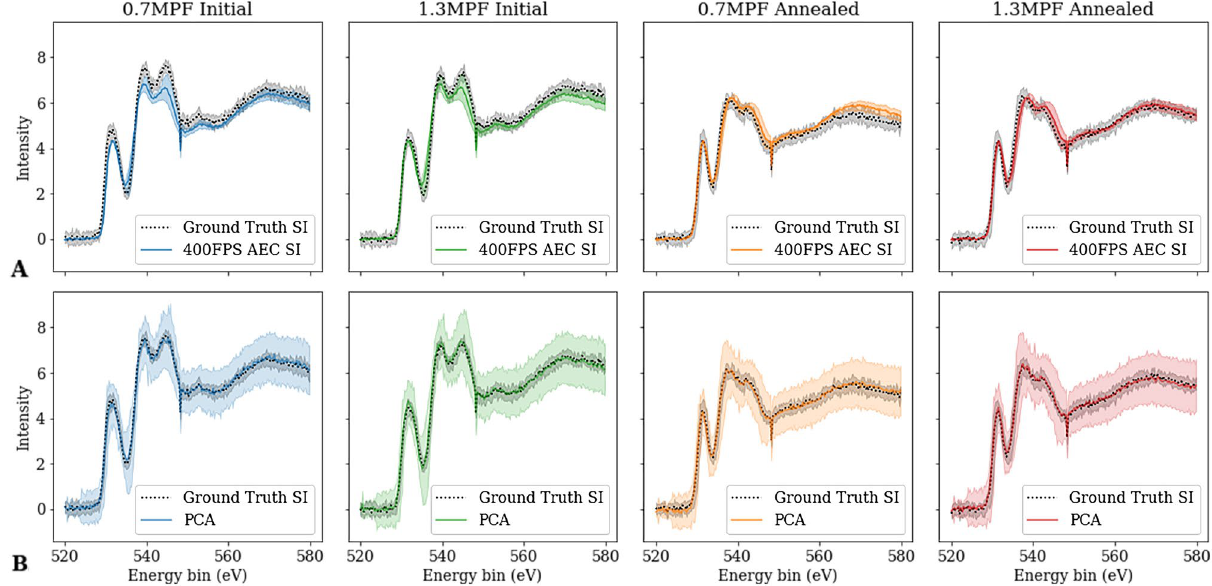
Figure 6. Visual comparison of the four test datasets, at varying oxidation state and sample thickness. Solid lines are the average of the SI and corresponding shaded region is the standard deviation. ( A ) Average of AEC denoised 400FPS spectra (blue, green, orange, red solid lines) in a 40 by 10 pixel section. Corresponding Ground Truth spectra are superimposed with a gray dashed line. ( B ) Average 3 component PCA reconstruction of 400FPS spectra (blue, green, orange, red solid lines) in a 40 by 10 pixel section. Correspond Ground Truth spectra are superimposed with a gray dashed